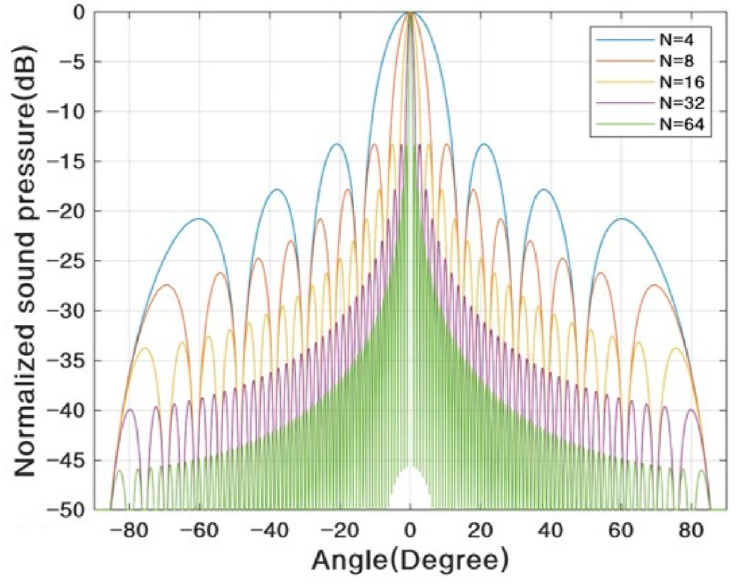
Figure 6. The influence of the element number on the directivity. Reproduced with permission from [58], Copyright 2022, MDPI AG.